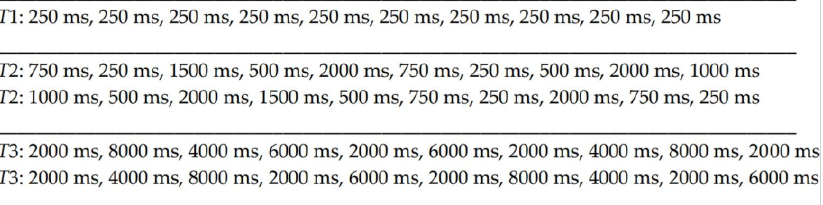
Figure 1. Examples of the distribution of ten consecutive RSIs in three main tasks. The T 1 always has the same short and regular interval of 250 ms. In task T 2, individual intervals are variable, but they fall within the range between 250 and 2000 ms, the longest RSIs occurs in 20% of all cases. As shown in the two examples, although the length of successive intervals was different as a result of computer-moderated randomization, the sum of the duration of all RSIs in the task is always the same, in both cases, it was 9500 ms. Similarly, two examples show the possibility of distributing consecutive intervals in the T 3 task, in which the RSI segments range from 2000 to 8000 ms. As in task T 2, the successive RSIs were different, but the sum of all of them in both examples is the same, 44,000 ms. Partial randomization of the distributions of individual intervals was performed so that any fluctuations in reaction times associated with IIV did not result from the fact that the longest intervals, which according to theoretical assumptions should generate the largest range of IIV, always occurred in the same parts of the